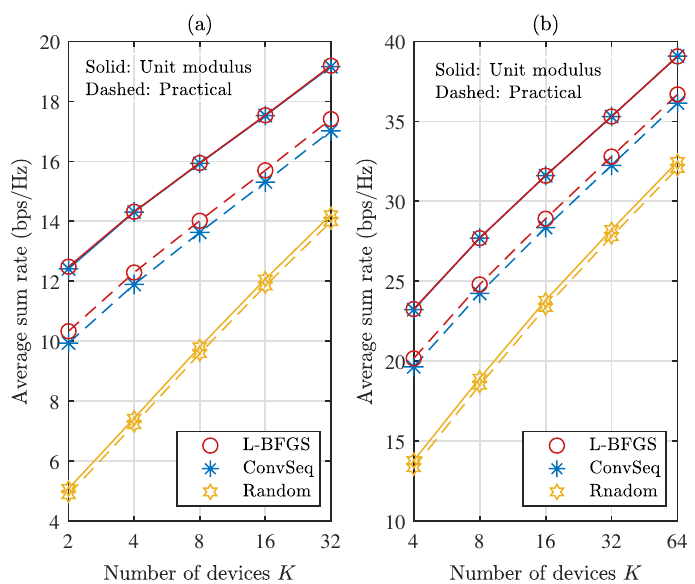
Figure 6. Average sum rate as the number K of devices increases when N = 256: ( a ) M = 2 ( b ) M =